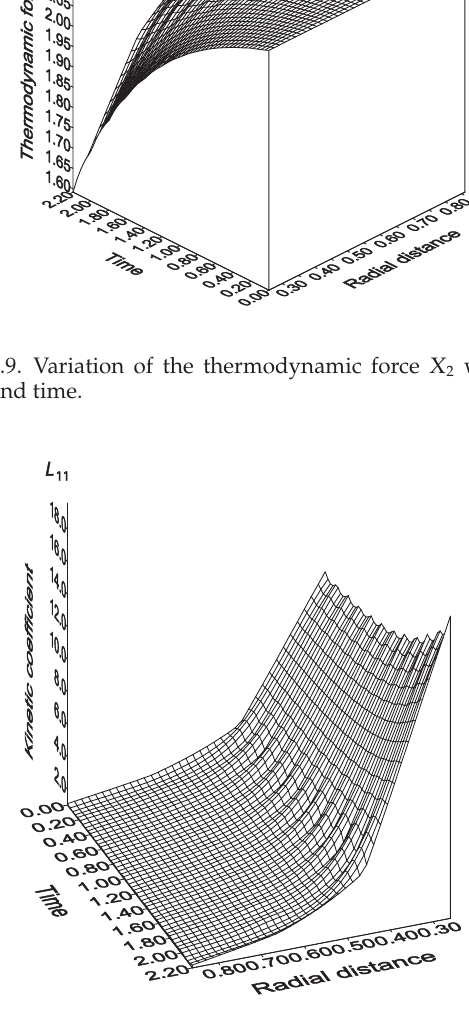
11 with radial dis-